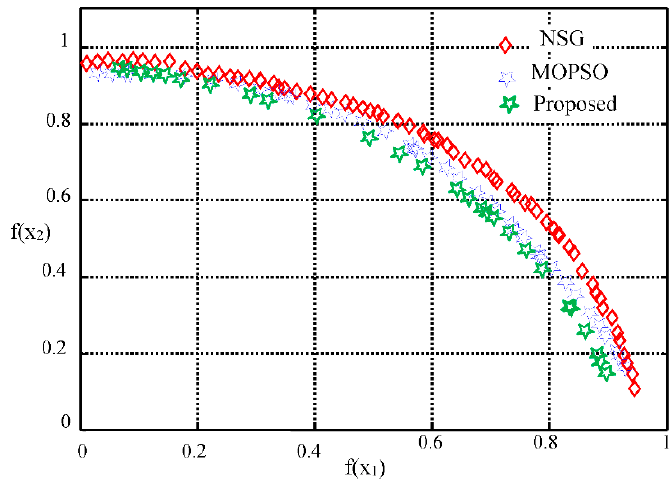
Figure 12. Pareto front of reformed ZDT2 issue by two aim functions.